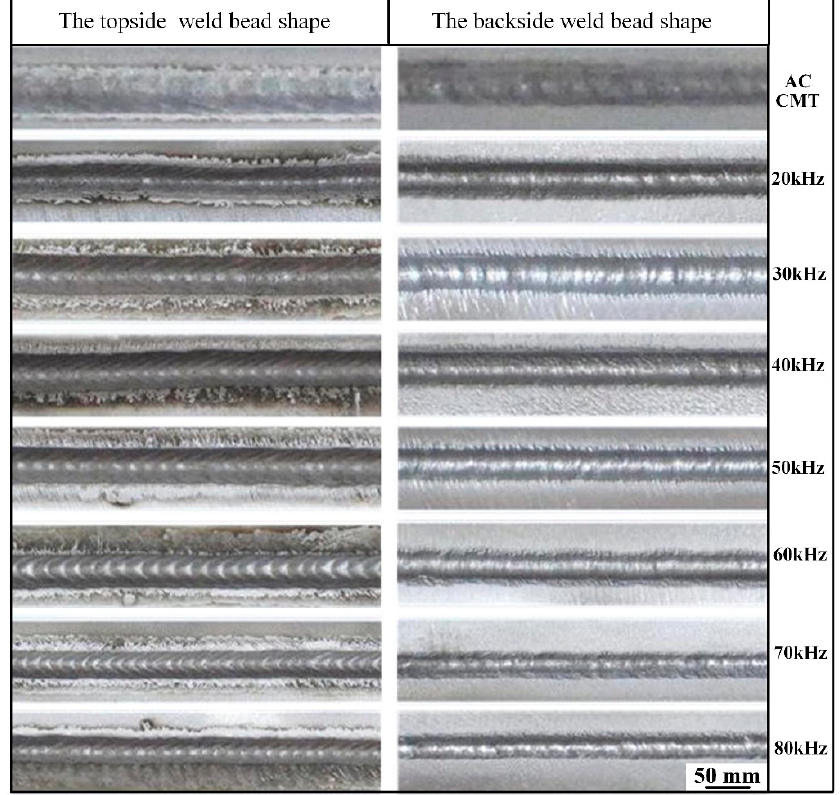
Figure 3. The topside and backside weld bead shape welded by AC CMT and AC CMT coupled current at frequency of 20 kHz, 30 kHz, 40 kHz, 50 kHz, 60 kHz, 70 kHz, and 80 kHz, respectively.